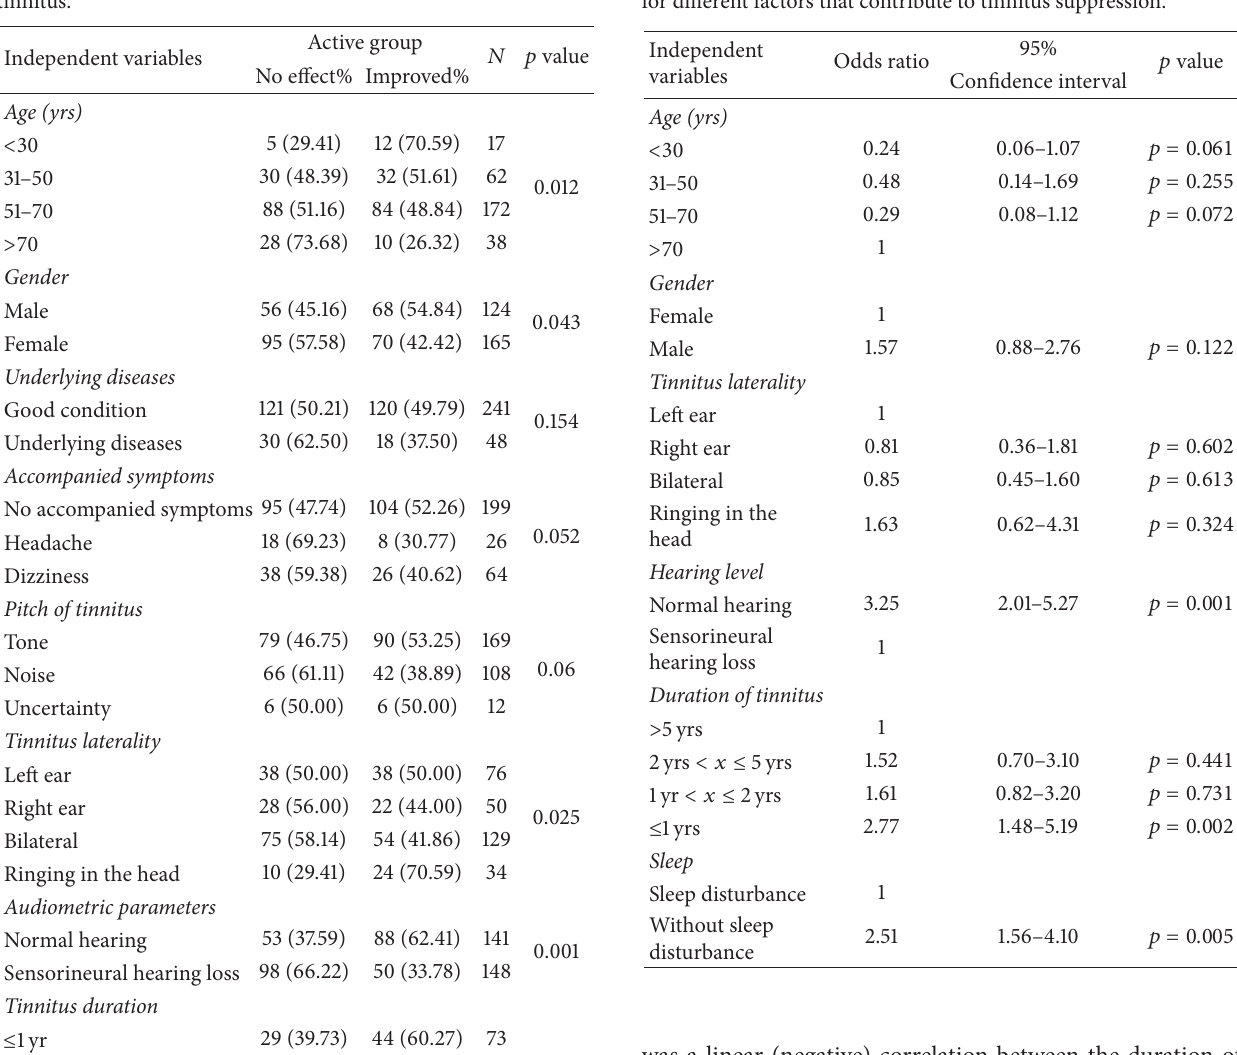
Table 1: Clinical characteristics of the patients suffering from tinnitus.